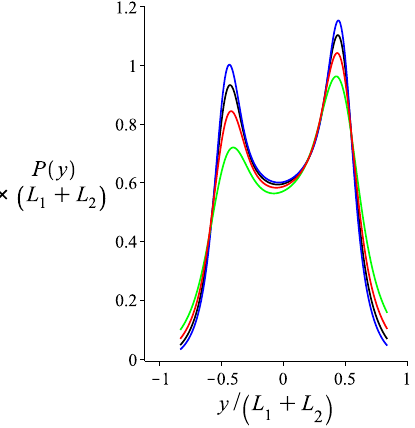
Figure 6. The probability density of the y coordinate of the position of the tip of two filaments jointed by a harmonic orientational spring, as shown by Equation (16). The green, red, black and blue colours correspond to l p = 18 µ m, l p = 27 µ m, l p = 36 µ m and l p = 45 µ m, respectively. The fixed parameters for all curves are: L 1 = 3 µ m; L 2 = 3 µ m; ω = 0; θ B = π K h = 0.005; and l p 1 = l p 2 = l p .